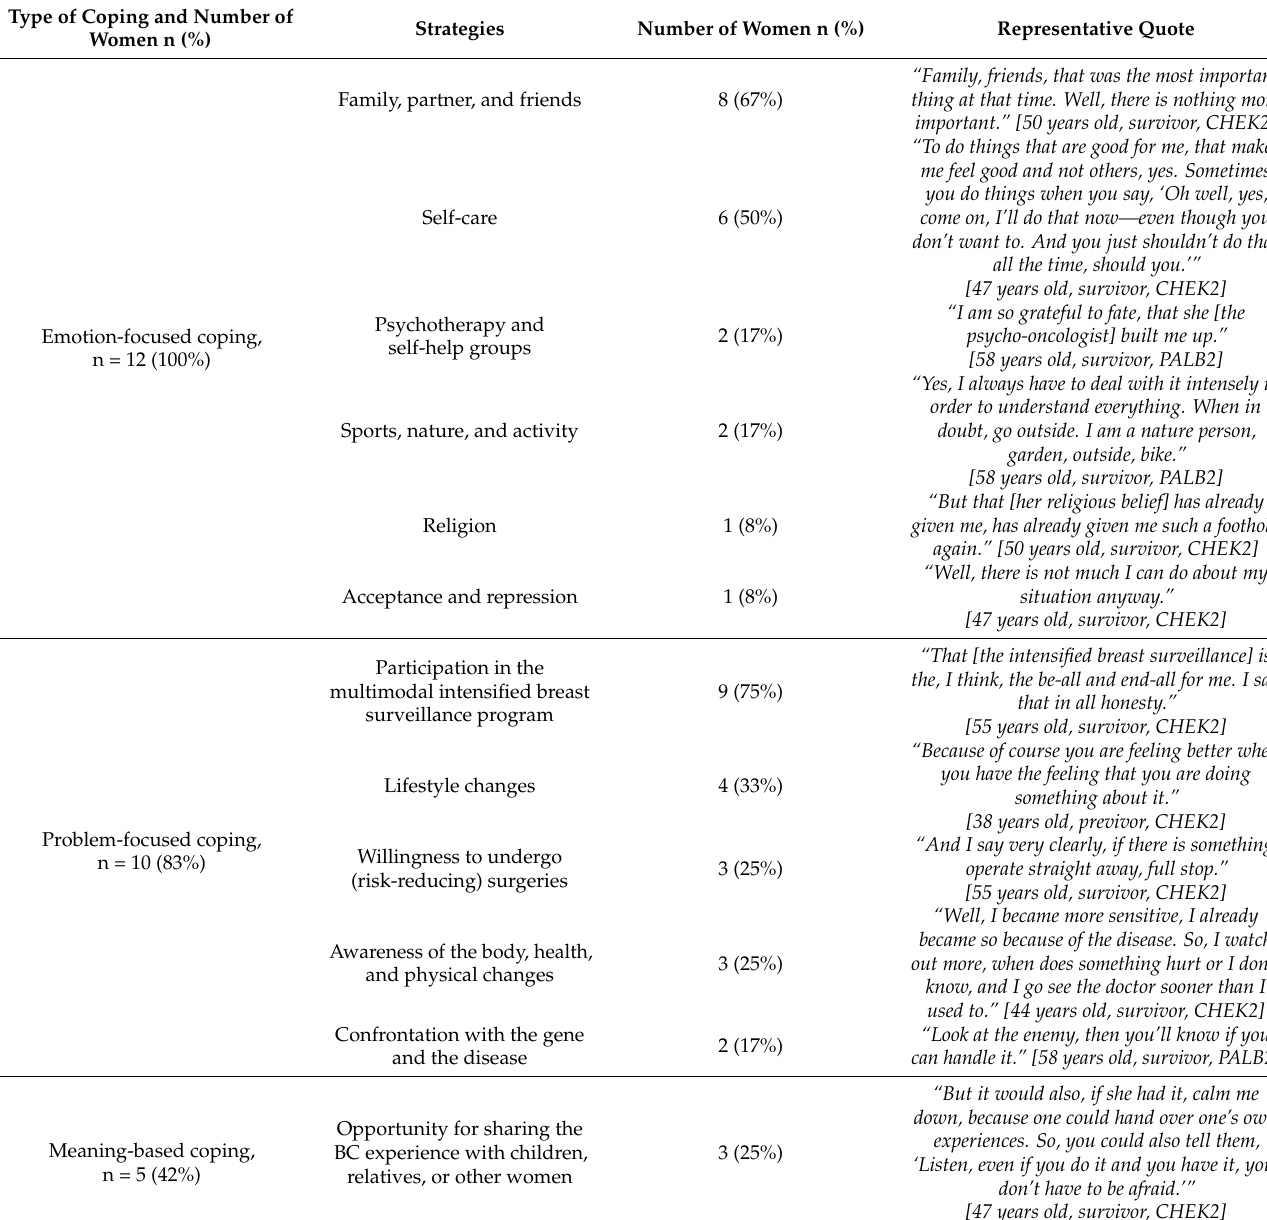
Table 5. Overview of the different types of